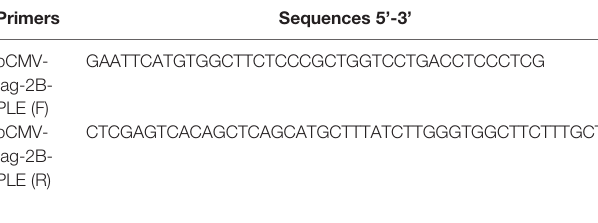
TABLE 1 | The primers for subcloning cDNA of PLE.